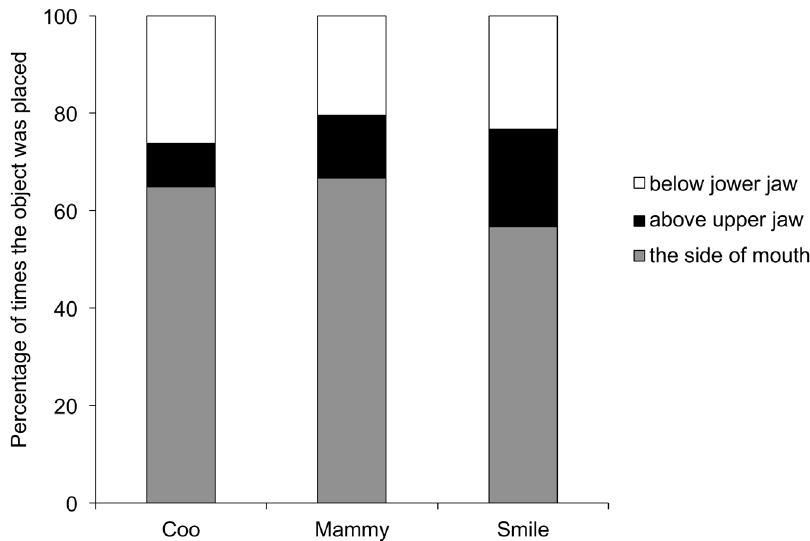
Figure 1. Object placement at each location. The ratio of object placement at each location for the total observed bouts for each individual. The legend indicates the location at which the object was placed. Placement to the side of the mouth indicates no object manipulation and placement below the lower jaw and above the upper jaw indicate object manipulation.